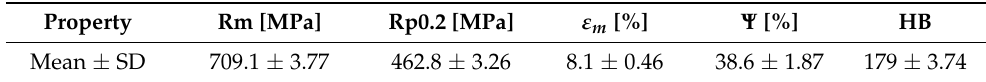
Table 2. The mechanical properties of C45E steel (SD—standard